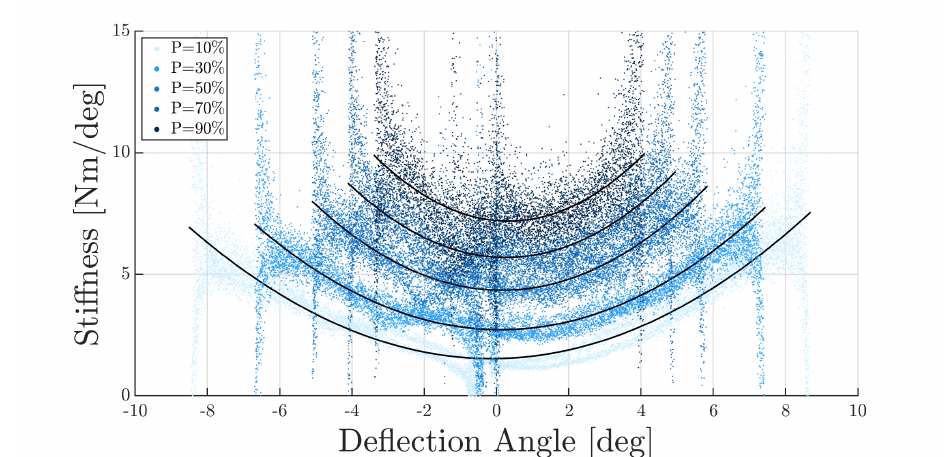
Figure 11. Quasi-stiffness characteristics of the SMARCOS obtained by numerical differentiation of the curves shown in Figure 10. At maximal deflection, the torque value drops when passing from loading to unloading, whereas the deflection angle remains locally constant. This causes infinite slopes in the quasi-stiffness curves, which are represented by the vertical lines at maximal deflection. The full lines correspond to 2nd order regression fitted on the experimental